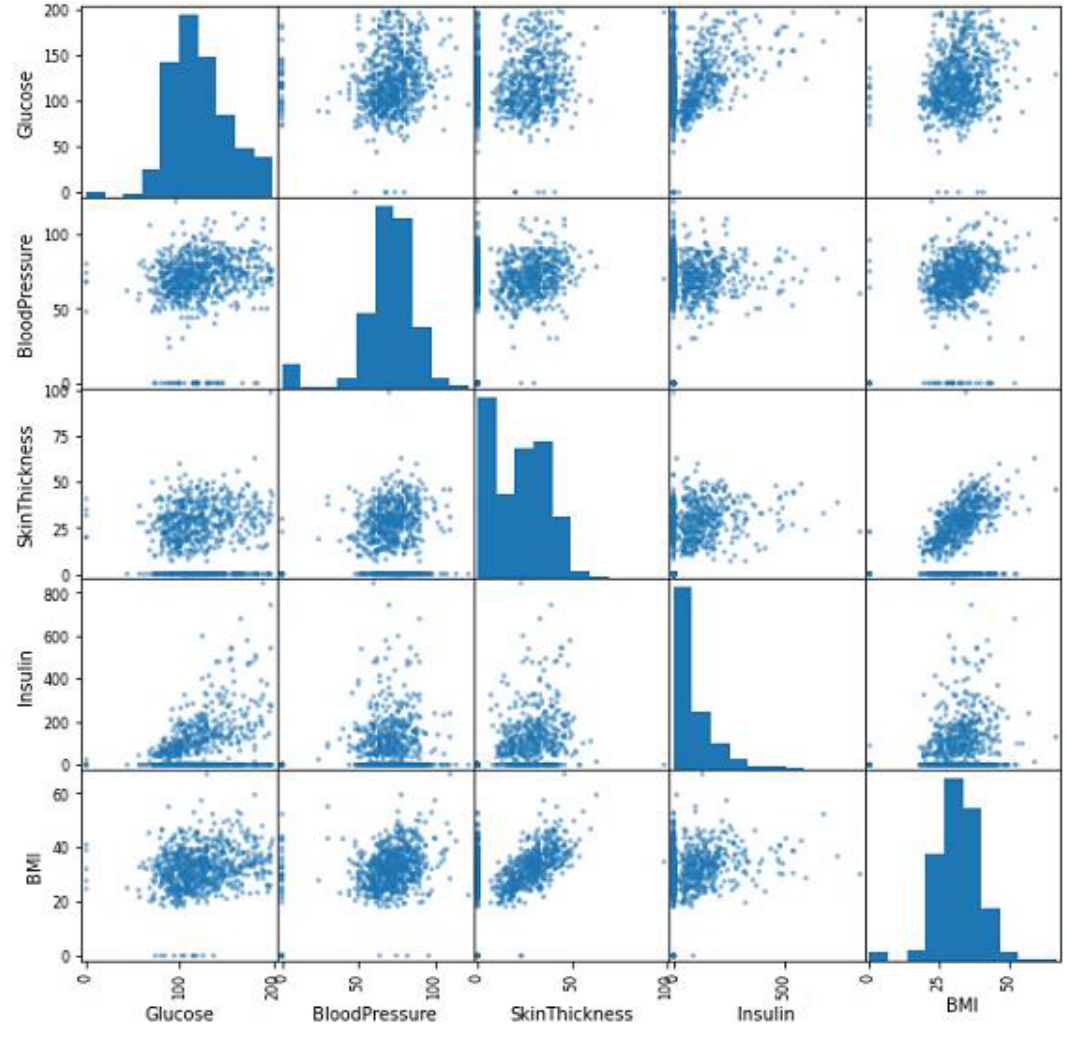
Figure 1. Distribution of missing attributes for the Pima diabetes dataset Table 3. The descriptive statistics of the Pima diabetes